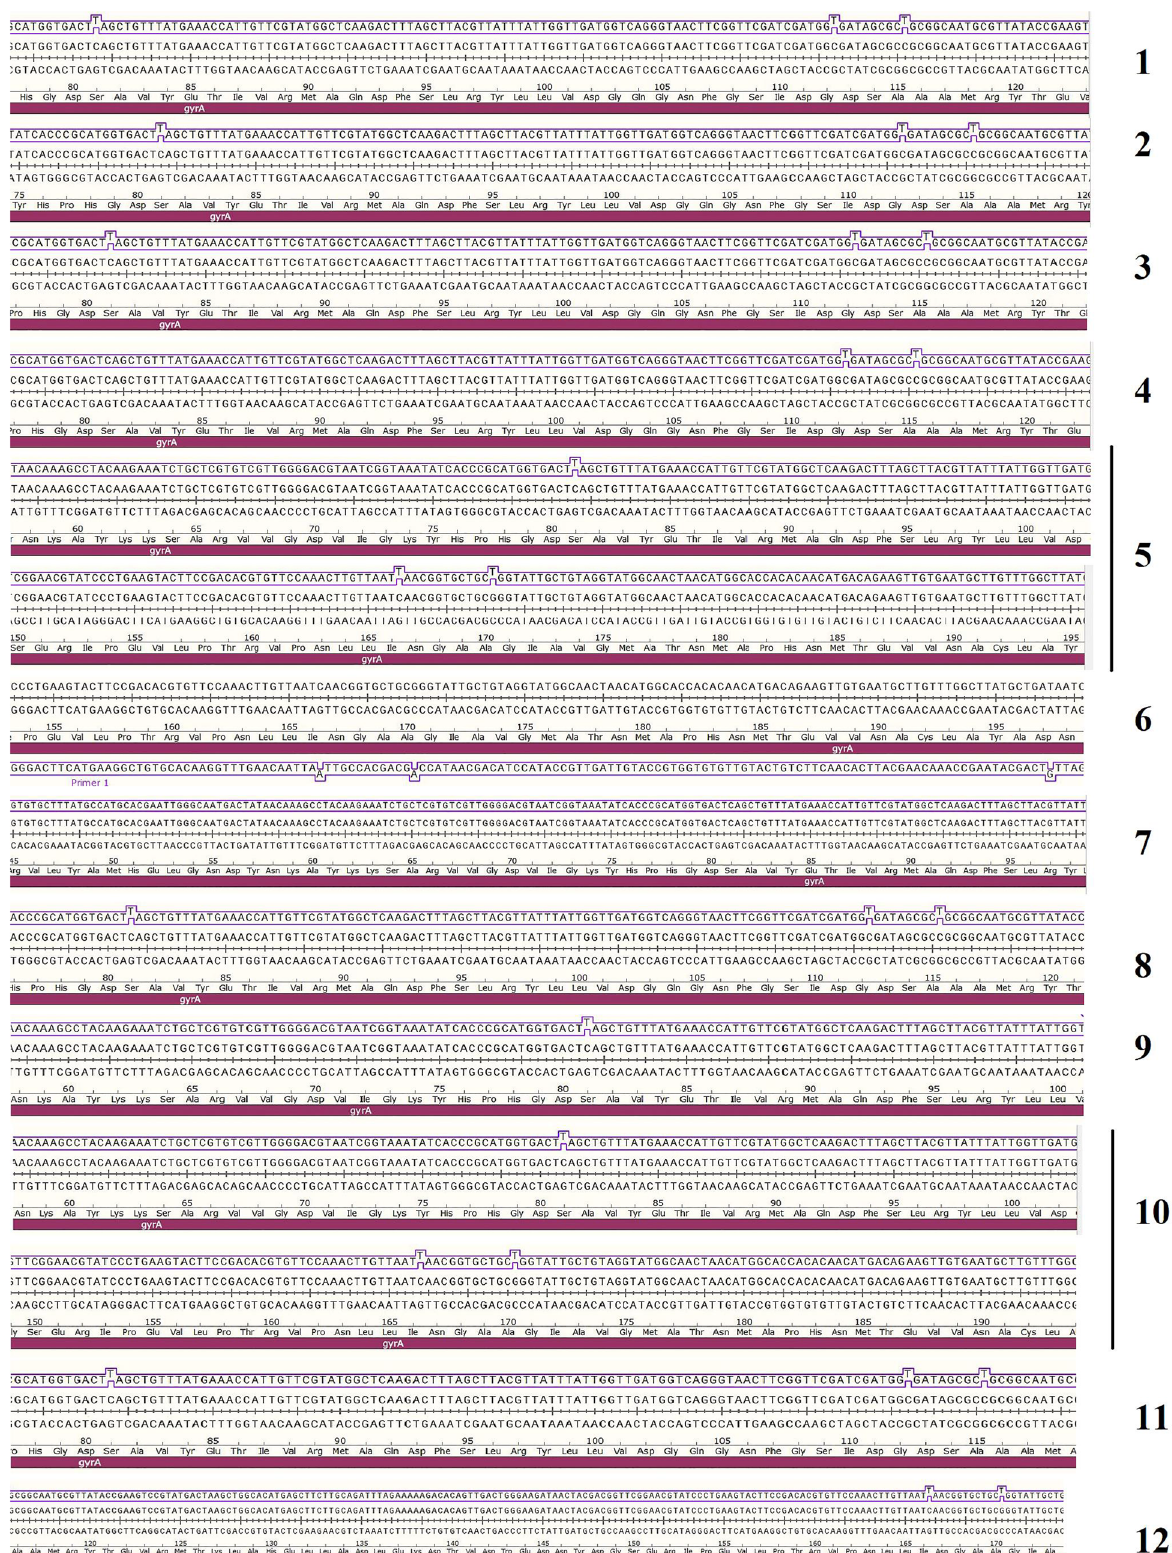
Figure 3. Pairwise alignment of nucleotide sequences (CDS region) of gyrA genes of 12 tested A.baumannii isolates versus the wild type gene of A.baumannii ATCC 19,606 retrieved from the GeneBank database using SnapGene Viewer